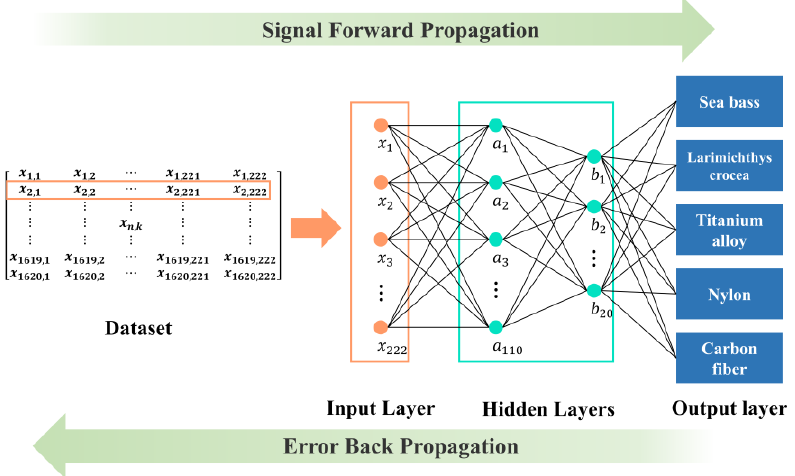
Figure 6. The BP neural network we constructed in this paper. The input data contains 222 data points. There are 110 neurons in the first hidden layer and 20 neurons in the second hidden layer. The final output is mapped to five categories.